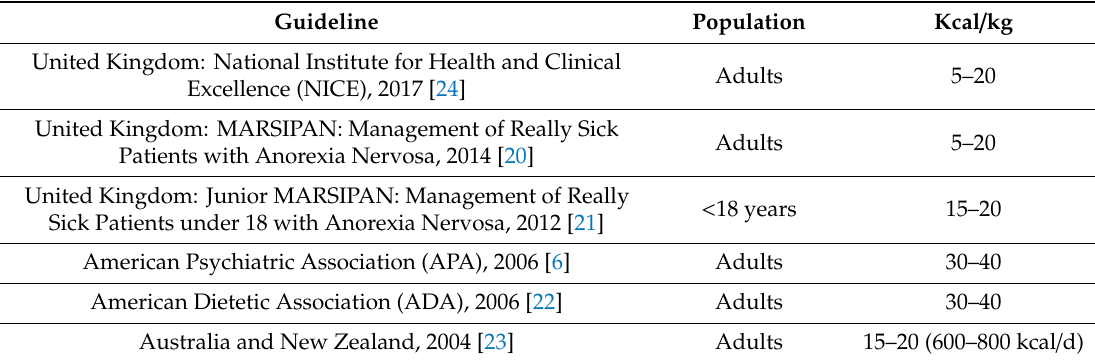
Table 4. Guidelines for the refeeding of malnourished anorexia nervosa patients.